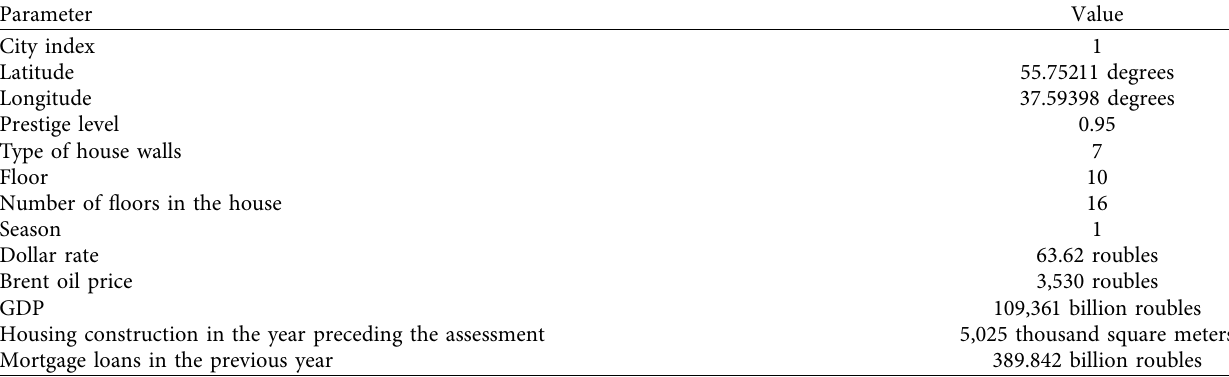
Table 2: Input parameters of the model that characterize a house in Moscow, its geographical location, evaluation time, and the cor- responding economic situation in the world, country, and region.